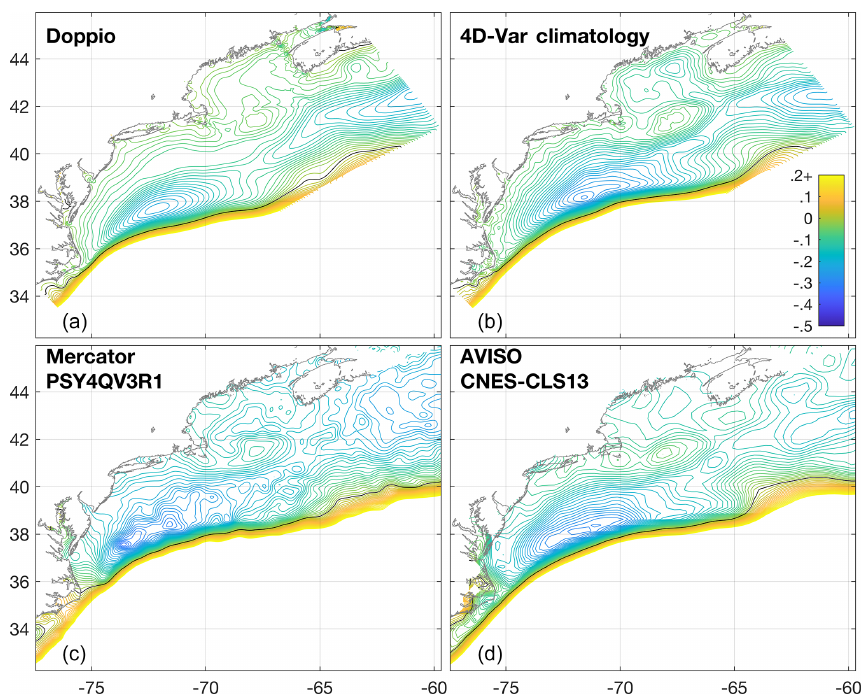
Figure 15. Mean dynamic topography (MDT) (meters) in the model domain. (a) Five-year (2007–2012) mean of Doppio. (b) Our 4D-Var climatology analysis. (c) Mercator product. (d) Global AVISO